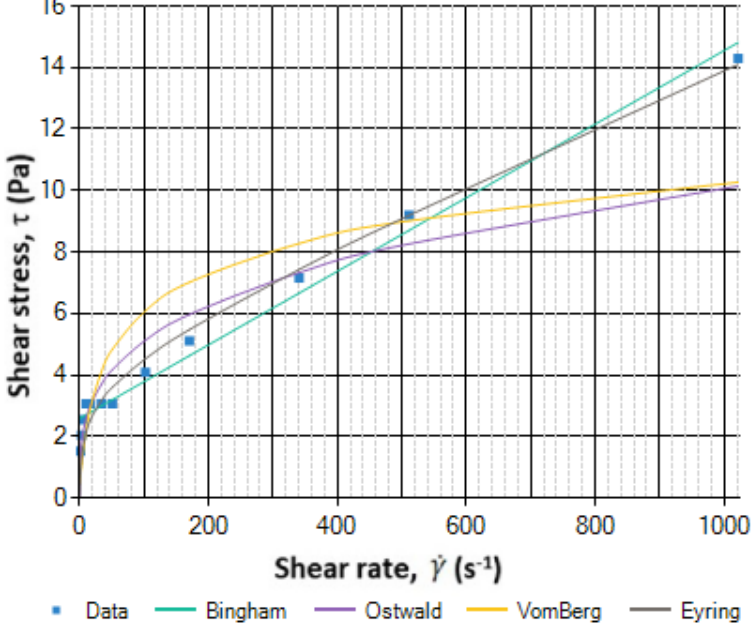
Figure 9. Comparison of the selected rheological models, 3% drilling mud.